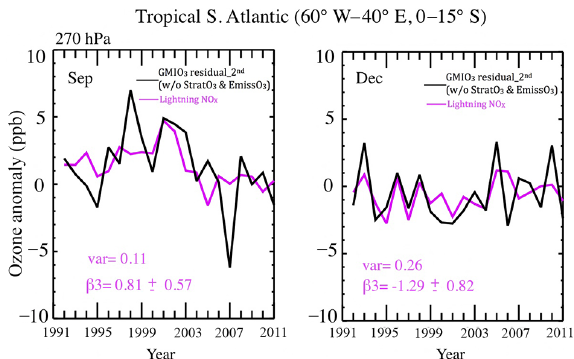
Figure 15. The comparison between regression of lightning NO x (magenta) and the ozone residual after removing the regression of StratO 3 and EmissO 3 (black) at 270hPa in September (left) and December (right) over the tropical South Atlantic region. The in- creased variance explained by the regression by adding lightning NO x (var), regression coefficient ( β) , and its 95% confidence level are labeled in each